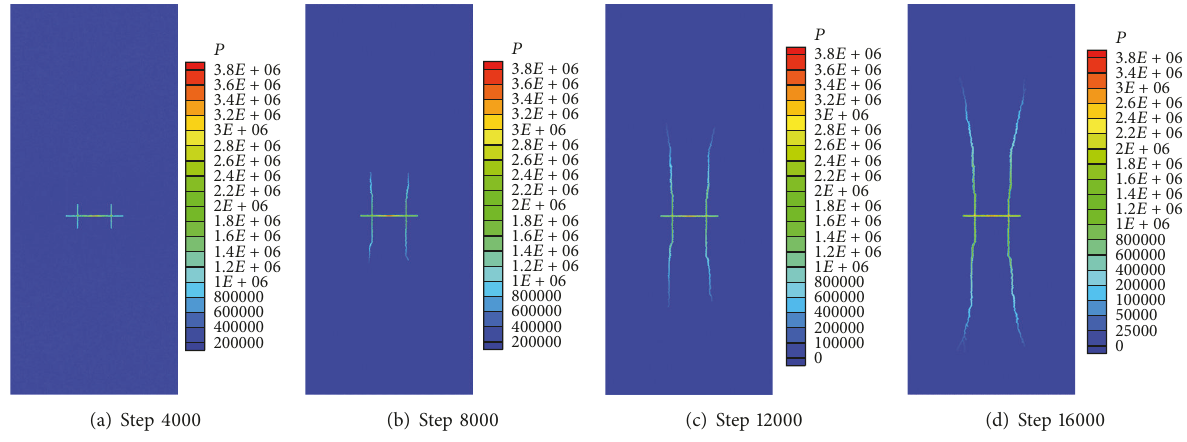
Figure 22: Propagation of two initially parallel fractures driven by hydraulic pressure: anisotropic in situ stress field.